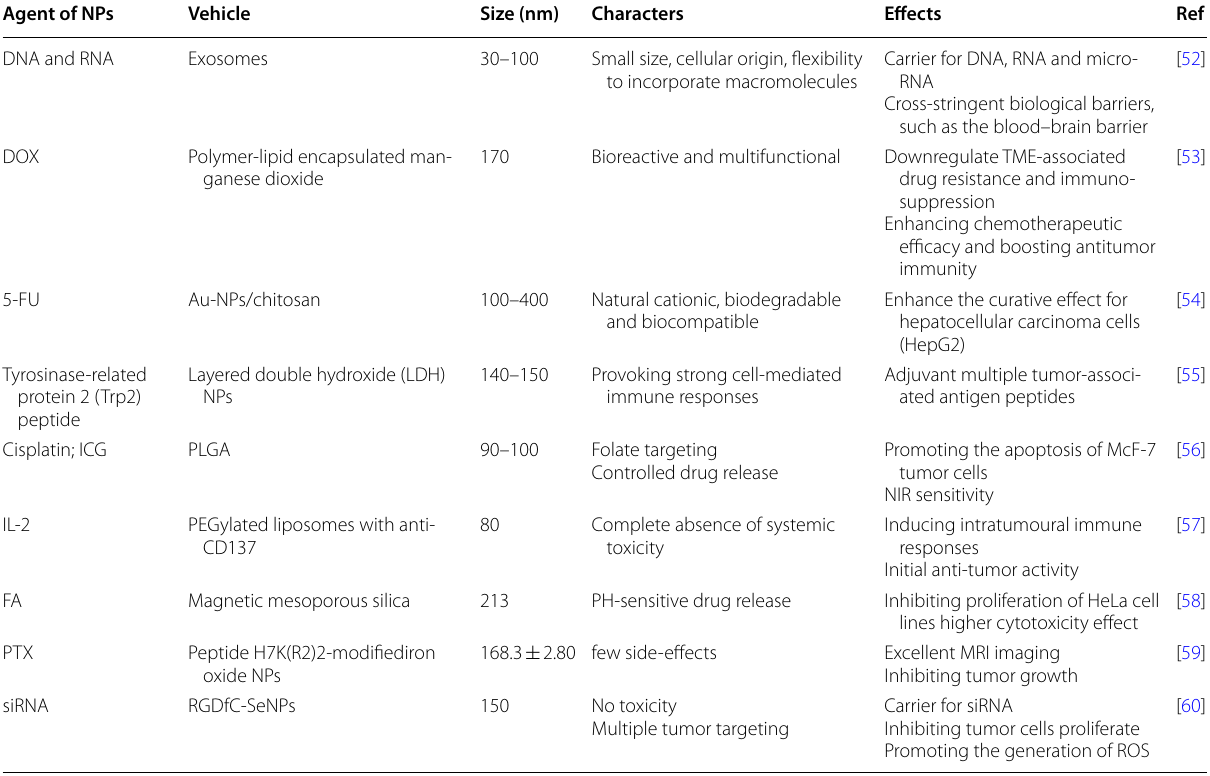
DOX doxorubicin, 5-FU 5-fluorouracil, FA folic acid, PTX paclitaxel, ROS reactive oxygen species